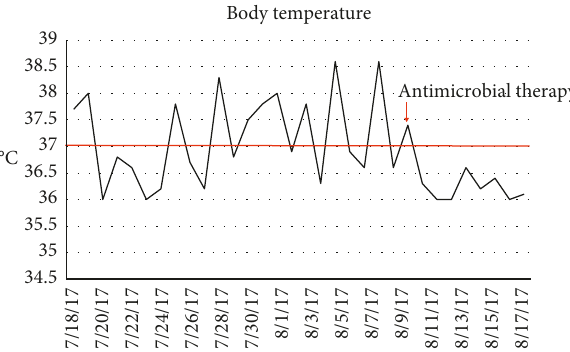
Antimicrobial therapy